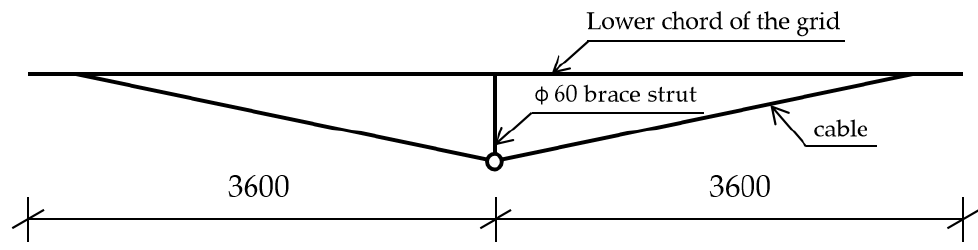
Figure 13. Design of the cable-stayed structure model used in the test.